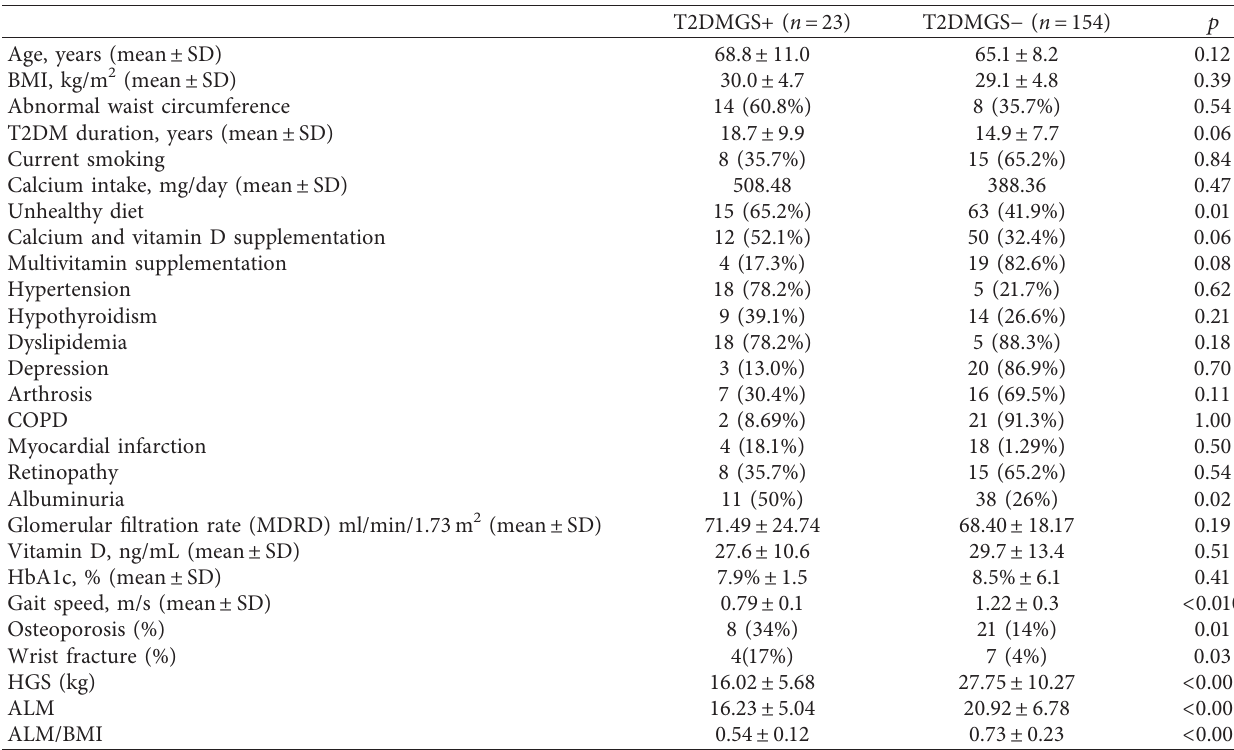
Table 3: Variables associated with the presence or absence of sarcopenia in participants in the type 2 diabetes mellitus group